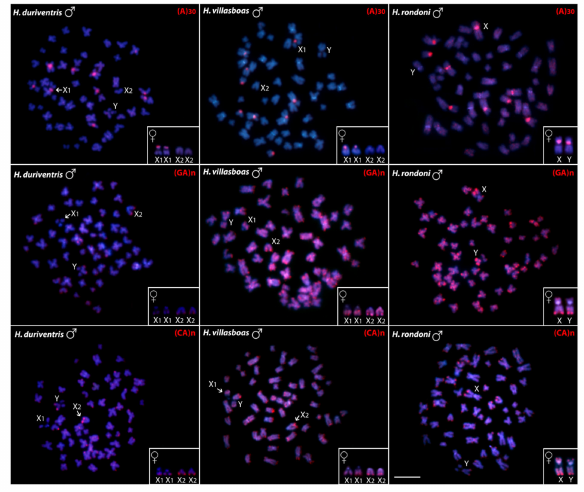
Figure 3. Metaphase chromosomes of males H. duriventris , H. villasboas and H. rondoni hybridized with microsatellite-containing oligonucleotides. Chromosomes were counterstained with DAPI (blue) and microsatellite probes were directly labeled with Cy3 during synthesis (red signals). The female sex chromosomes are shown in boxes. Bar = 5 µ m.